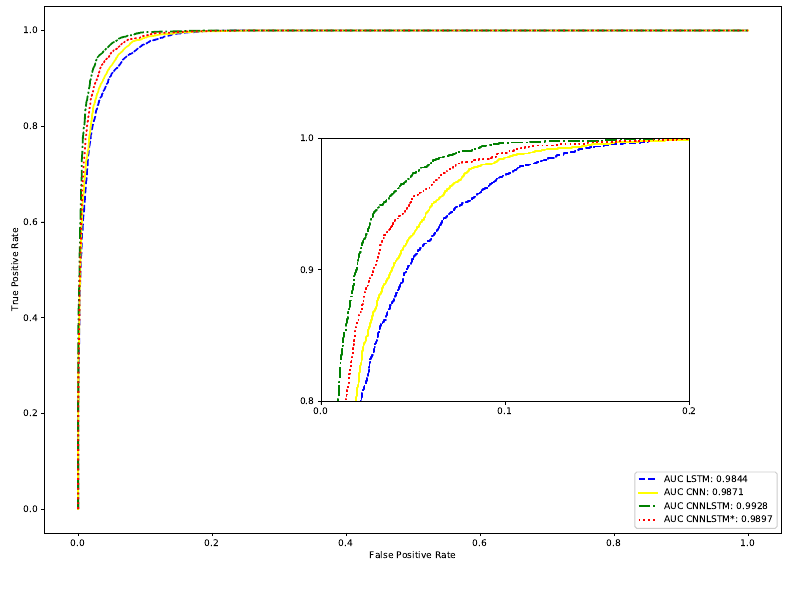
Figure 7. ROC curves of LOS identification using the proposed CNNLSTM and other